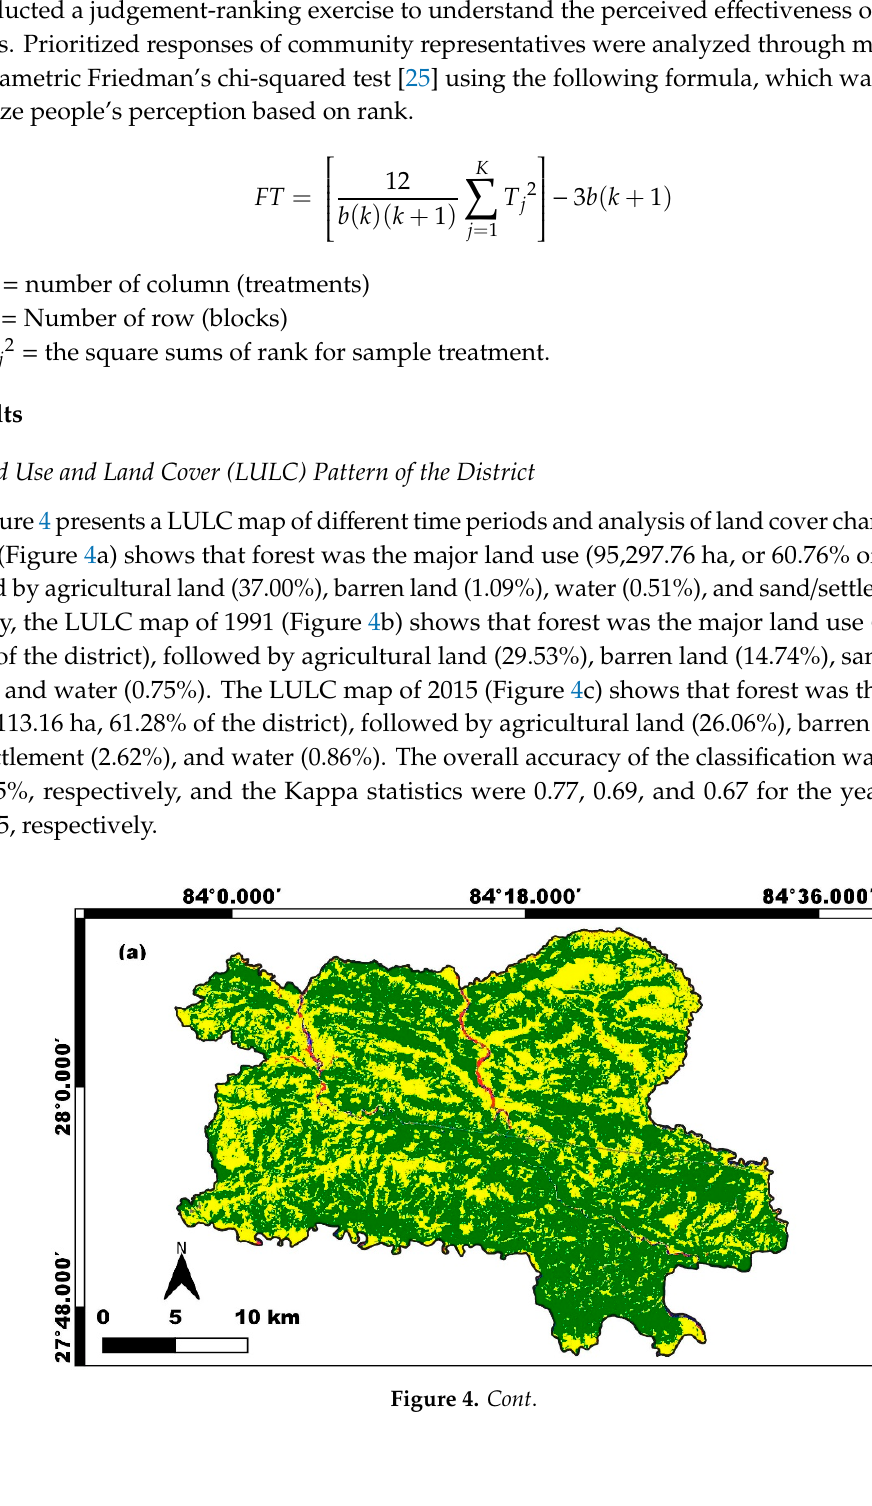
Figure 4. Land use and land cover map for ( a ) 1976, ( b ) 1991, and ( c ) 2015. 3.1.1. LULC Change Pattern for the Period 1976–1991 Barren land increased whereas forest and agricultural land decreased. Sand and settlement and water bodies were relatively stable with slight increment during this time period (Figure 5). The row total of Table 3 represents the percentage of total area covered by each class in 1976 (e.g., the total value of the second row is 1.09%, which was the land percentage covered by barren land in 1976). The column total of Table 3 represents the percentage of total area covered by each class in 1991 (e.g., the total value of the second column is 14.74, which was the land percentage covered by barren land in 1991). The differences between the row total and column total represent the land cover changed